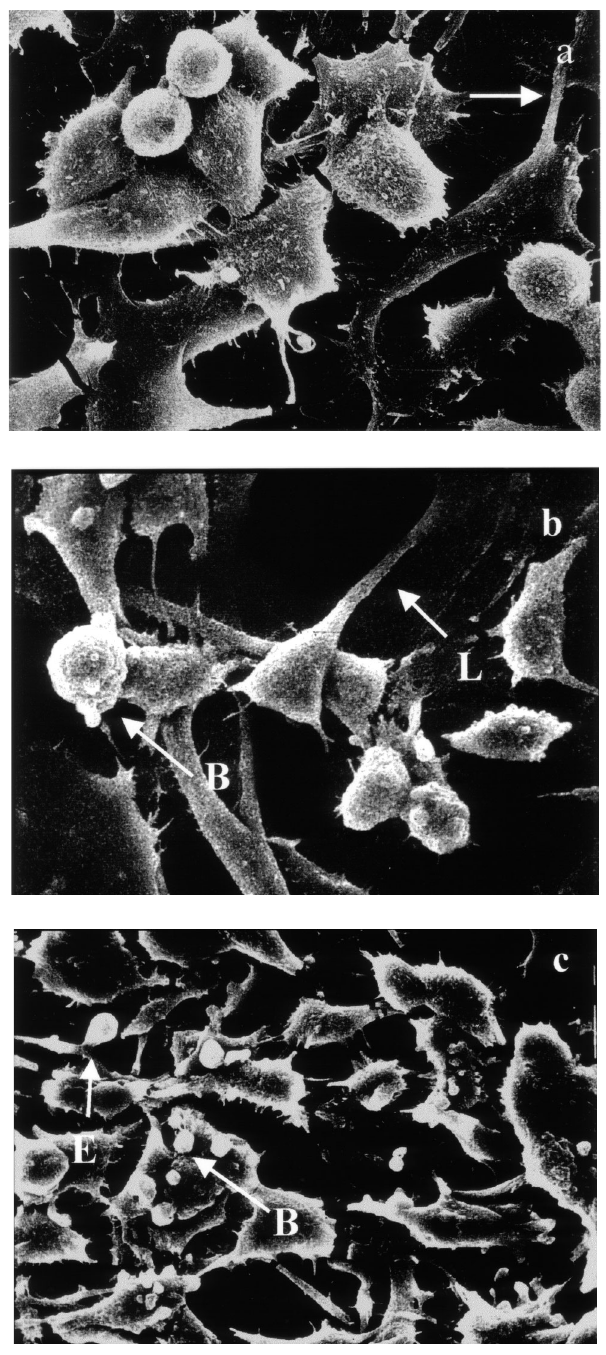
Figure 4:SEMmicrographsof surfaceultrastructuralcharacteristics of HeLa cells treated with and without tamoxifen. (a) Cell surface characteristics of 48 hours untreated HeLa cells showing numer- ous microvilli on the cell surface and lamellipodia extensions (L) ( × 1500 ). (b) Tamoxifen treated HeLa cells ( 48 hours, 5 µ g/ml) ex- hibiting cell surface blebbing (B) and narrowing of cells with elon- gated and shortened lamellipodia (L). Cell detachment is visible ( × 1800 ). (c) 48 hours treated (15 µ g/ml) HeLa cells depicting many blebs or apoptotic bodies (B) on the cell surface, broken lamellipo- dia, and cytoplasmic extrusions (E). Cell shrinkage and detachment are evident ( × 1500